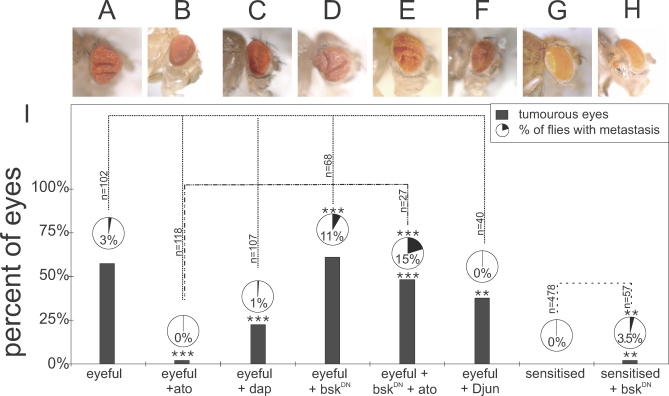

ato Functions by a JNK-Dependent Mechanism(A) ey-GAL4, UAS-Dl, eyeful/+ fly.(B) ey-GAL4, UAS-Dl, eyeful/UAS-ato.
(C) ey-GAL4, UAS-Dl, eyeful/UAS-dap.(D) bskDN/X; ey-GAL4, UAS-Dl, eyeful/+.(E) ato function depends on JNK activity: bskDN/X; ey-GAL4, UAS-Dl, eyeful/UAS-ato.(F) ey-GAL4, UAS-Dl, eyeful/UAS-Djun.(G) A sensitized genotype with eye-specific Dl overexpression leading to mild eye overgrowth: ey-Gal4, UAS-Dl/+.(H) bskDN/X; ey-GAL4, UAS-Dl/+.(I) Quantitative representation of the tumor burden in different genotypes. Each lane is a separate genotype. Gray bars show percentage of tumorous eyes; pie charts give metastasis incidence. Double asterisks (**) indicate p < 0.01; triple asterisks (***) indicate p < 0.001 as analyzed by chi-square test, and n represents number of flies analyzed.